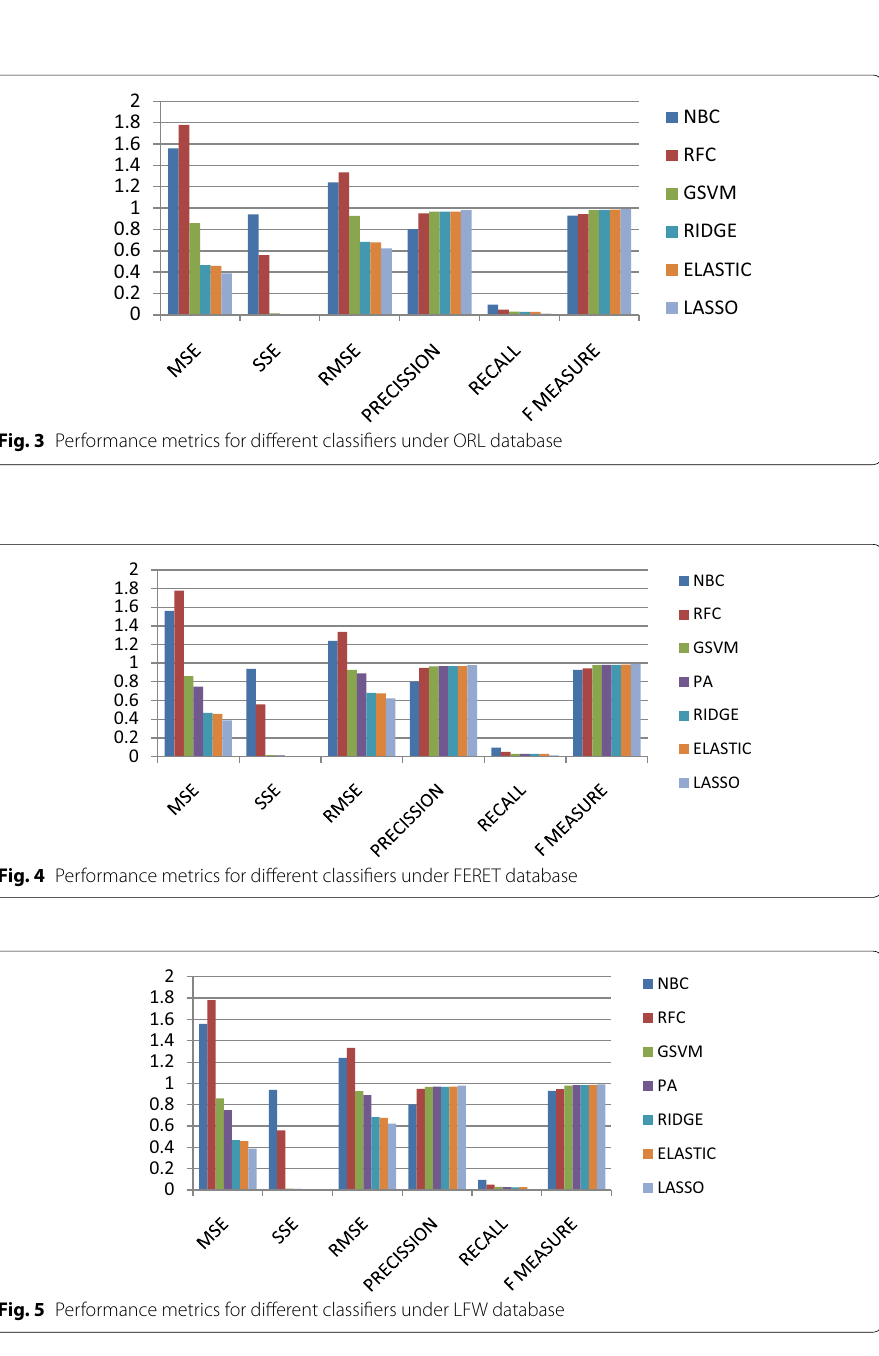
performance metrics and y-axis provides error rate for different datasetes, as the accu- racy was high and nearly 98.3% for all the datasets the performance were so closer and approximately equal to all the datasets.